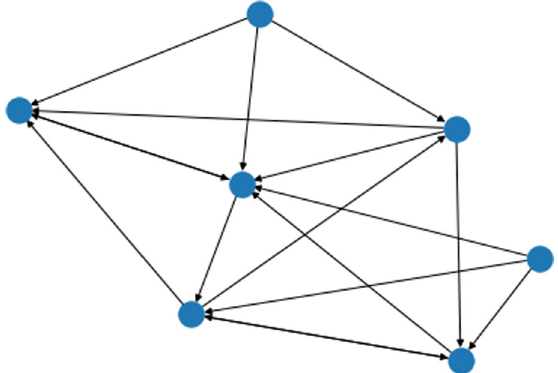
FIG. 1. Example of a complex network. Here the blue dots denote nodes (or students) and lines between the notes represent links (or edges). Directionality of the link is denoted by the direction of the arrow on each link.